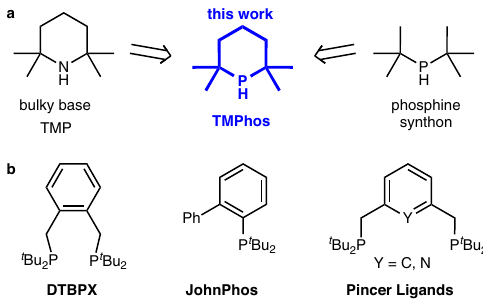
Fig. 1 Target phosphine synthon TMPhos. a TMPhos (2,2,6,6- tetramethylphosphinane) as the P-analogue of TMP and structurally related to t Bu 2 PH. b Well-known phosphine ligands containing -P t Bu 2 .